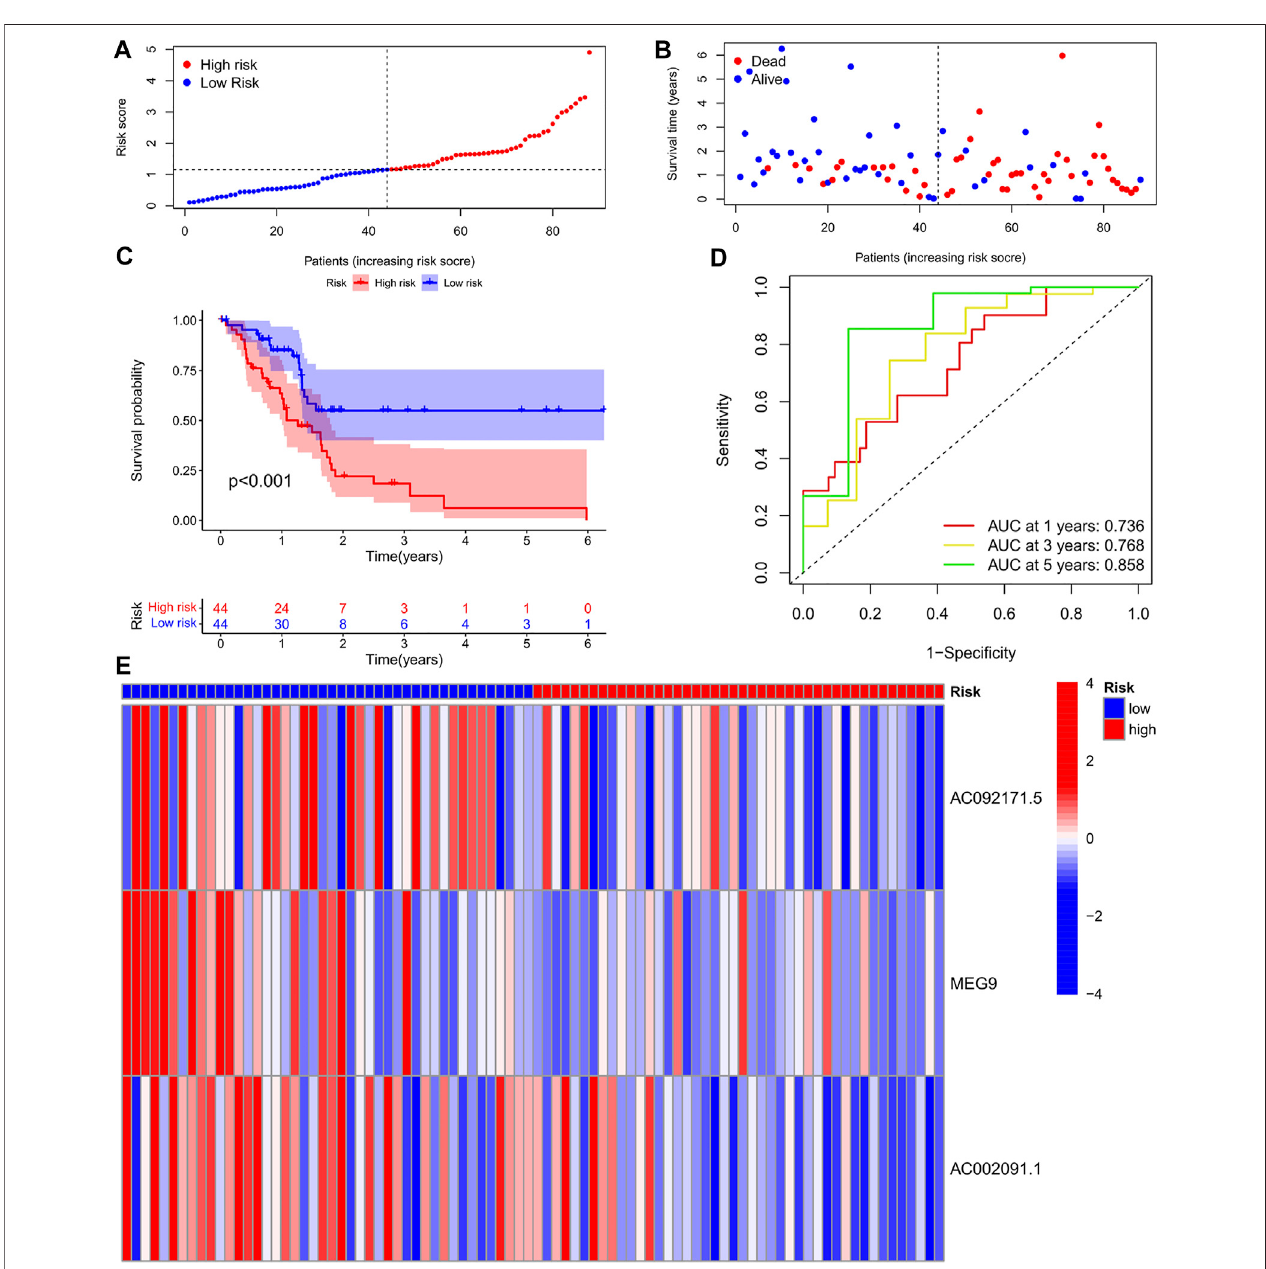
FIGURE 3 | (A) Survival status of patients in different groups in Training cohort. (B) Rank of prognostic index and distribution of groups based on m6A-lncRNA prognosticsignatureriskscoresintrainingcohort. (C) SurvivalstatusofpatientsindifferentgroupsinTrainingcohort. (D) Receiveroperatingcharacteristic(ROC)curves of the m6A-lncRNA prognostic signature for predicting the 1-year, 3-years, and 5-years survival in Train cohort. (E) heatmap of the m6A-lncRNA in Train